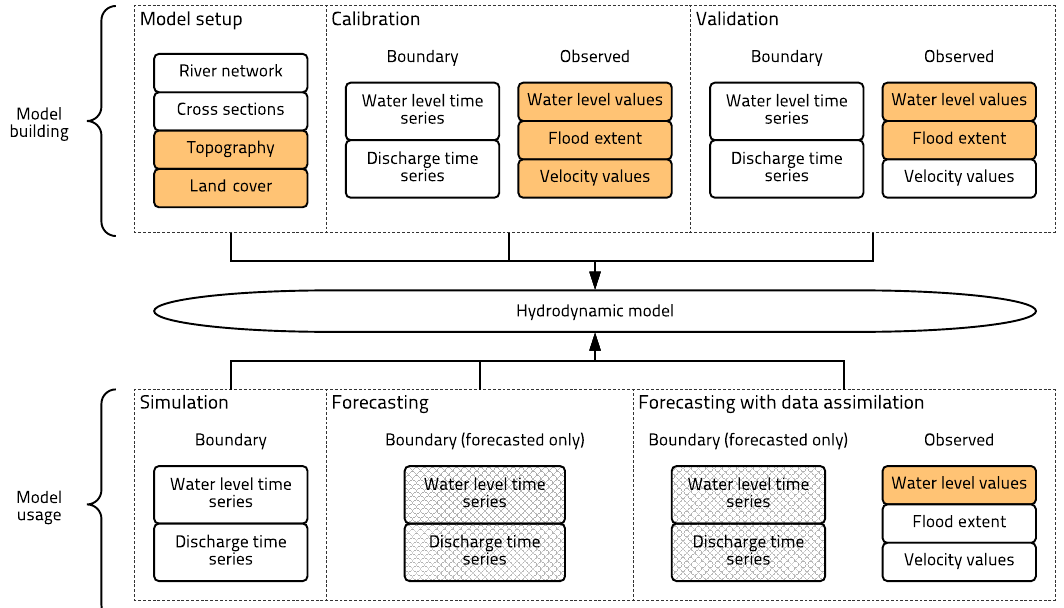
Figure 7. Flood models data requirements. Orange-coloured tiles correspond to data that citizens have contributed to in a flood modelling context and gridded tiles correspond to data citizens cannot contribute to (forecasted water levels and